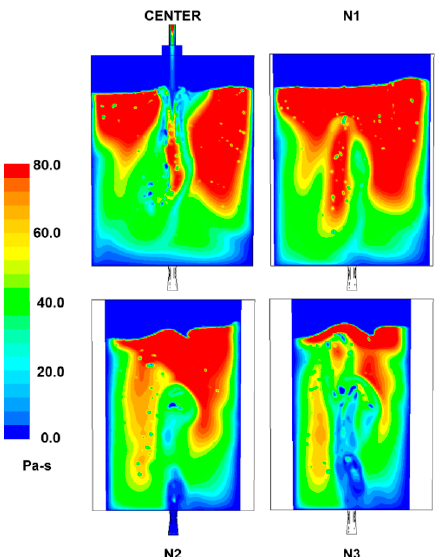
Figure 11. Fields of Turbulent viscosity (Pa-s) in planes of the North sector at a bath level of 80 tons.